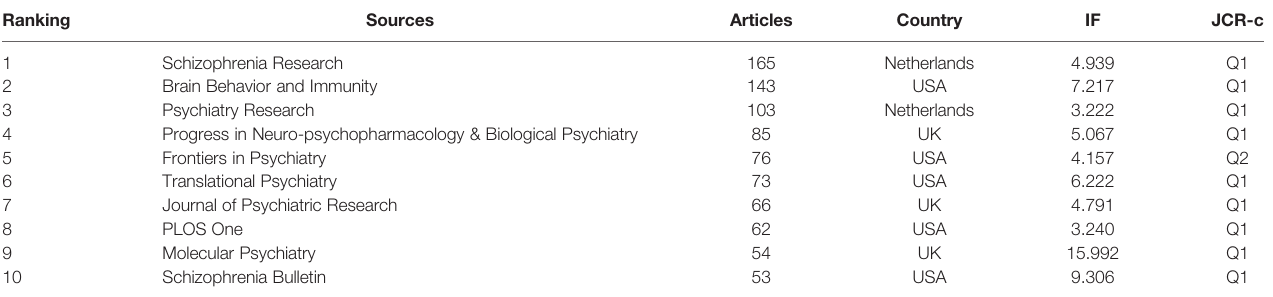
TABLE 1 | Top 10 journals with most publications in the fi eld of schizophrenia and in fl ammation research. Ranking